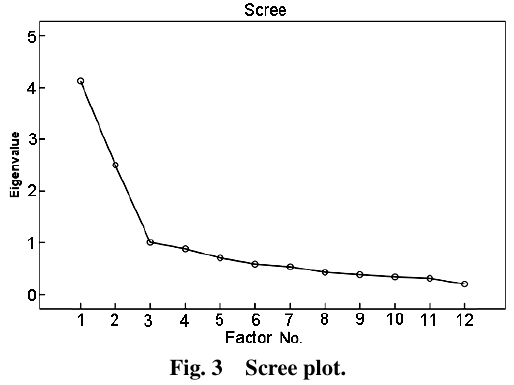
Fig. 3 Scree plot.